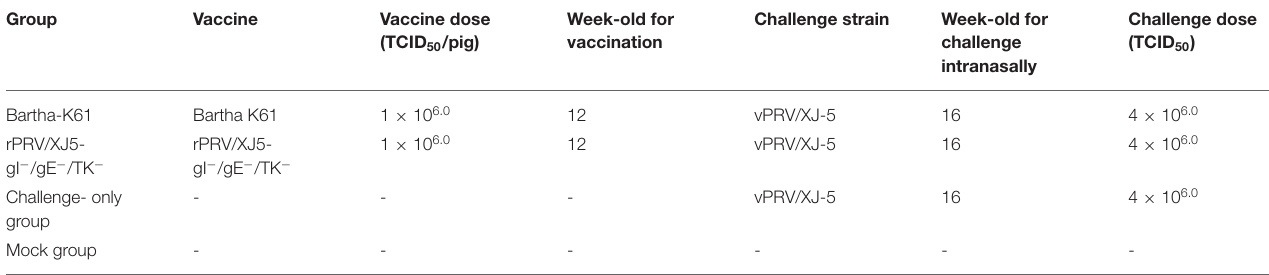
TABLE 1 | Grouping and treatments in different groups. Group Vaccine Vaccine dose